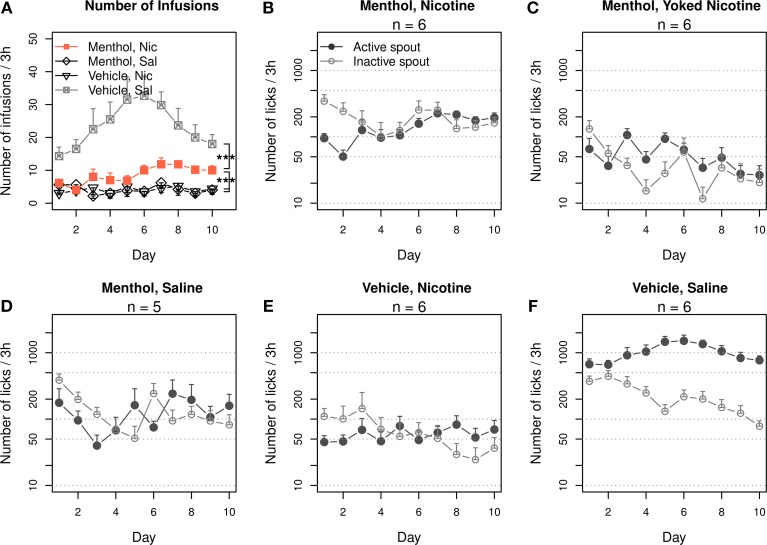
Contingent oral menthol supports stable i.v. nicotine self-administration. (A) Female adolescent Sprague-Dawley rats received concurrent oral menthol (or vehicle) cue and i.v. nicotine (or saline) upon the completion of a fixed-ratio 10 reinforcement schedule on the lickometer. The number of infusions obtained per session by the menthol-nicotine group was significantly greater than that obtained by the menthol-saline and vehicle-nicotine groups, indicating that the contingent delivery of menthol and nicotine is critical for increased intake. (B–F) The numbers of active and inactive licks by all four treatment groups and one additional group of rats yoked to the menthol-nicotine group. A log scale was used for the y-axis. Only the menthol-nicotine group significantly increased the number of active licks and sustained the level of responses across the sessions, confirming the reinforcing effect of the menthol-nicotine stimuli. With the exception of the vehicle-saline group, none of the groups exhibited a preference for the active spout, suggesting that despite being reinforcing, neither menthol nor nicotine produced a positive affective state (see Figure 6). ***
p < 0.001.